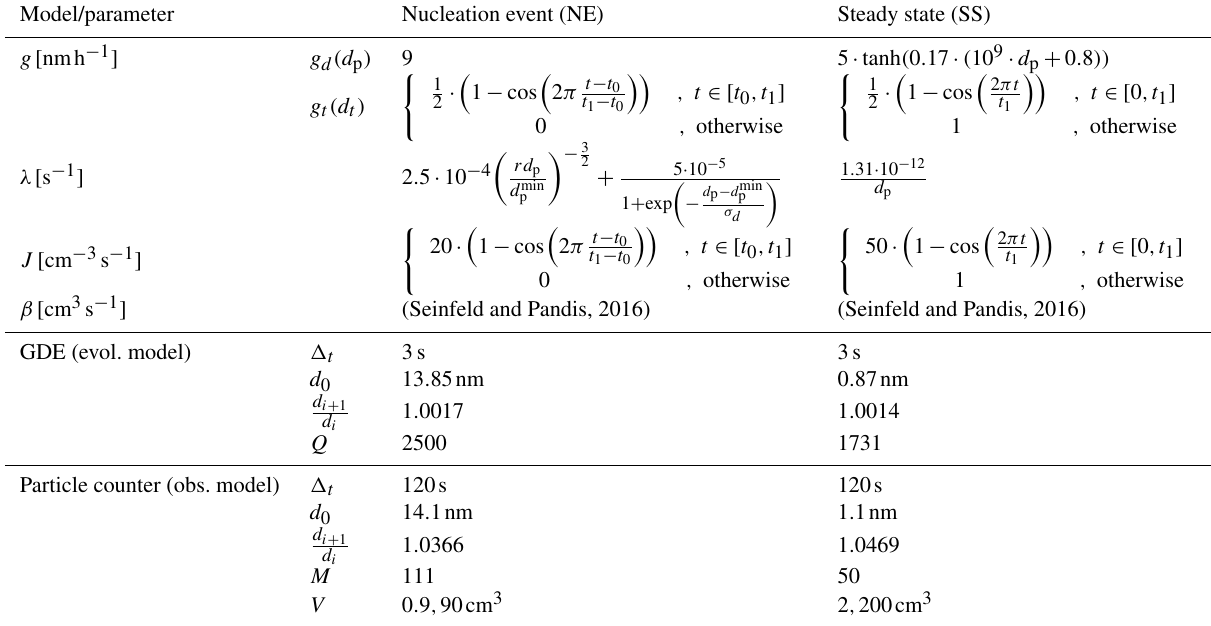
Table A1. Summary of the models and parameters used for simulating data in nucleation event (NE) and steady-state (SS) cases. Here, the growth rate g is assumed to be a product of a size- and time-dependent parts – that is, g = g d (d p )g t (d t ) . “evol.” denotes “evolution”, and “obs.” represents “observed”.